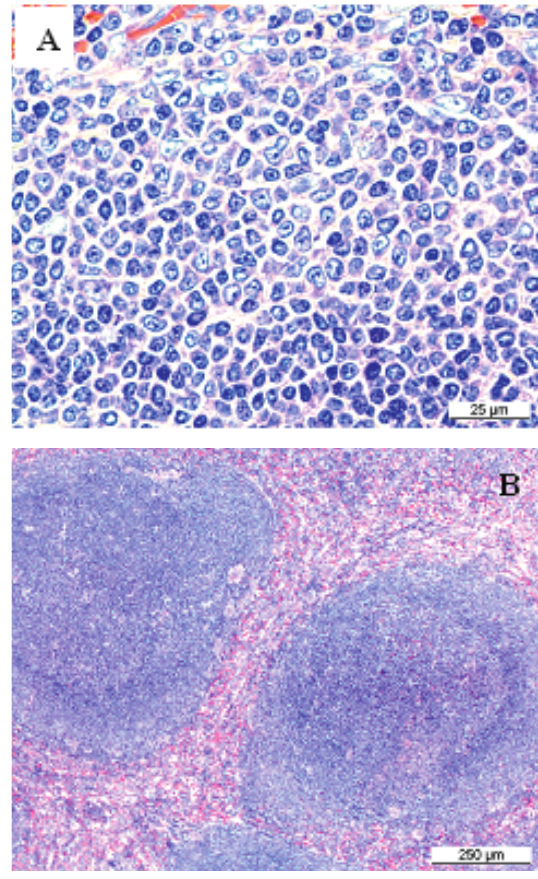
Figure 3: Representative micrographs of splenic marginal zone lymphoma (MZL). A) Splenic MZL and B) splenic MZL with low-magnification view of the growth